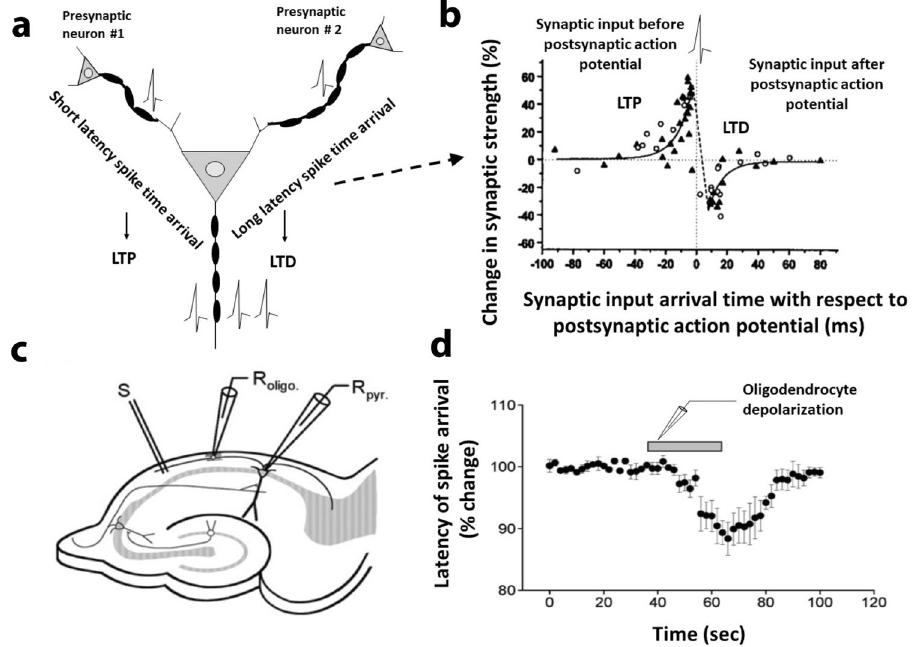
Fig. 1 Oligodendrocytes in spike-timing-dependent plasticity. By altering conduction velocity in afferents converging onto a postsynaptic neuron, myelin plasticity can induce spike-timing-dependent synaptic plasticity by determining the synchrony of spike time arrival with respect to postsynaptic action potential fi ring. a Effect of action potential latency in spike time arrival on synaptic plasticity. Arrival of synaptic input coincident with or prior to postsynaptic neuron fi ring, due to rapid conduction velocity or shorter axon path length, will result in long-term potentiation (LTP). Longer latency in spike time arrival, due to slower conduction velocity or longer axon path length, will lead to long-term depression (LTD). b Critical window for synaptic LTP and LTD in Xenopus tectal neurons. The percent change in the EPSC of synaptic inputs after repetitive stimulation (at 1 Hz for 100 s) plotted against the time of action potential input. Open circles represent repetitive spiking induced by injection of depolarizing currents. Impulses arriving within 20 ms before postsynaptic neuron fi ring become strengthened (i.e., LTP) while impulses arriving 20 ms after postsynaptic neuron fi ring are weakened (i.e, LTD). Adapted from Zhang et al. 94 , with permission. c , d Oligodendrocytes modulate conduction velocity. c Dual, whole cell recoding in hippocampal CA1 pyramidal neurons and oligodendrocytes. d Time-course of the latency of action potential arrival after depolarization of an oligodendrocyte forming myelin on that axon. The gray bar indicates time when oligodendrocytes were depolarized. Depolarization of oligodendrocytes increases action potential conduction velocity, and theta burst stimulation of axons depolarizes oligodendrocytes through glutamate receptors and potassium channels. Error bars = SEM. Adapted from Yamazaki et al., (2007) 32 with